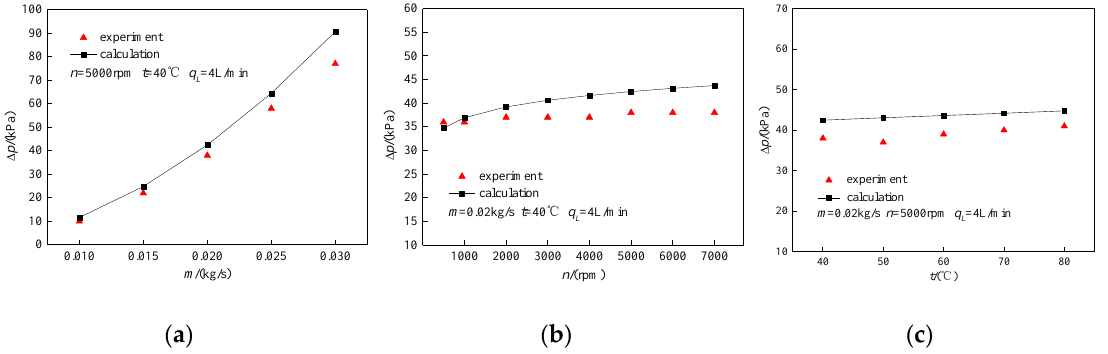
Figure 8. Ventilation resistance. ( a ) Ventilation rate; ( b ) rotating speed; ( c ) temperature.